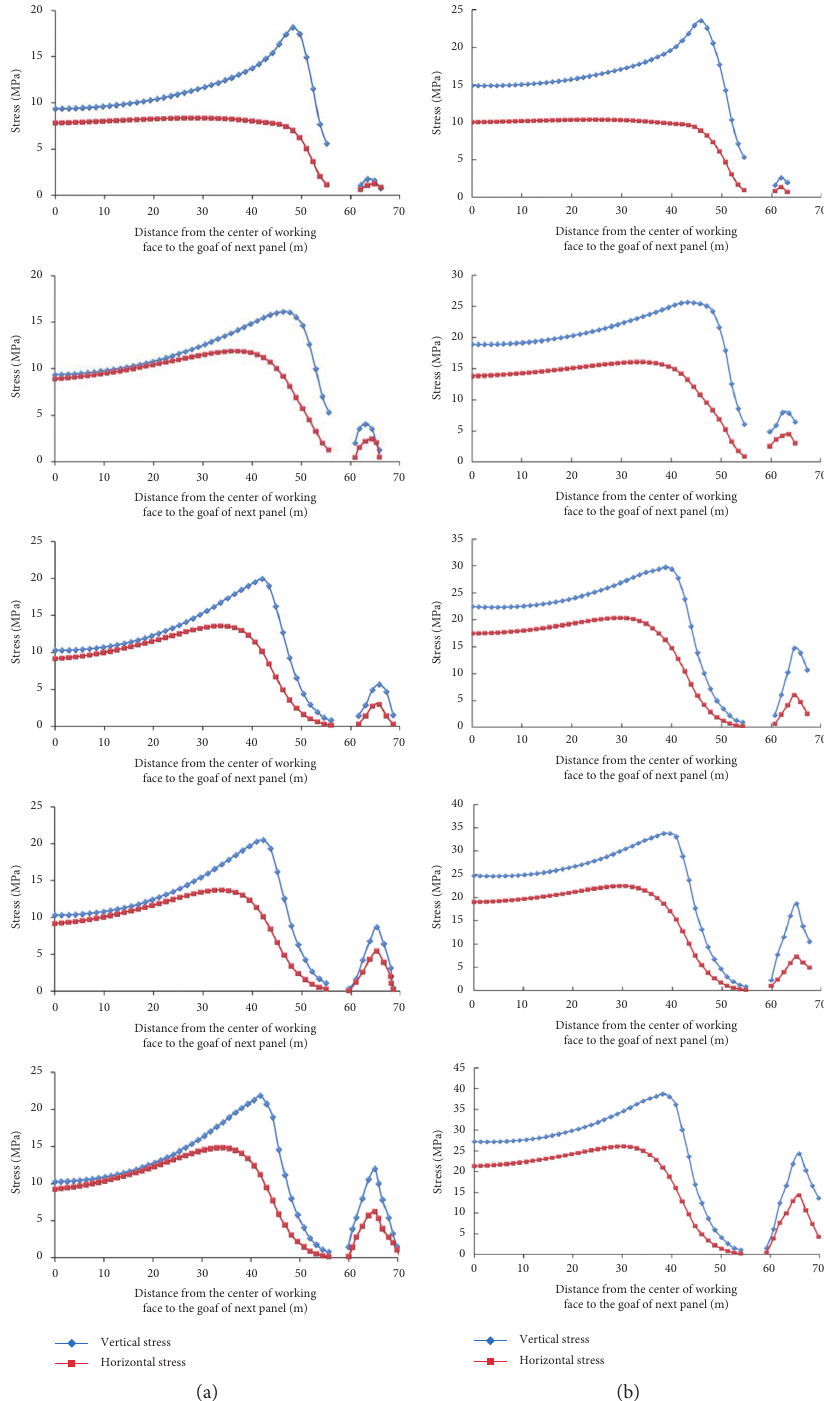
Figure 9: Stress distribution of different coal pillars during roadway driving and extraction periods. (a) The roadway driving period. (b) The extraction